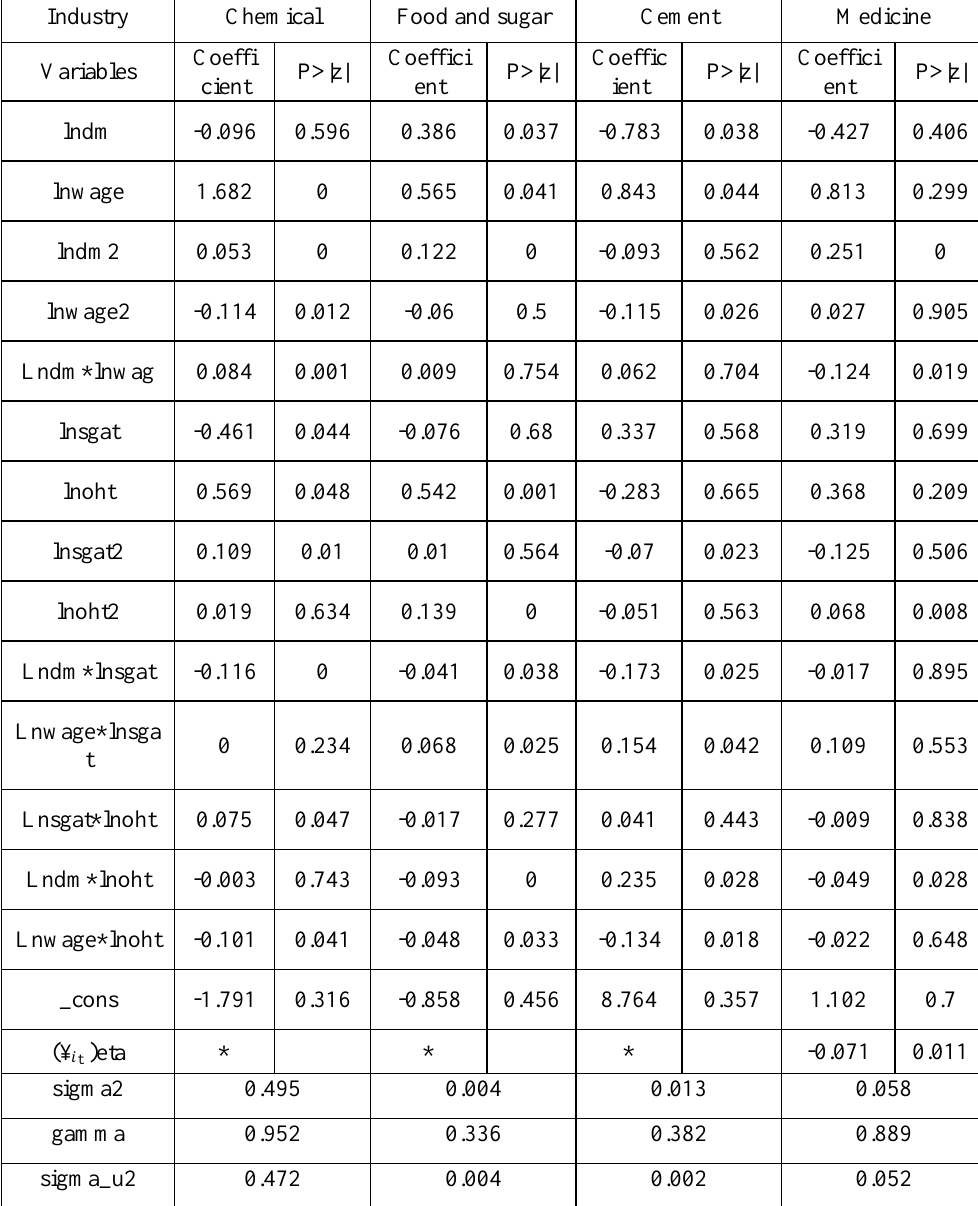
Table 3. Maximum likelihood estimation model